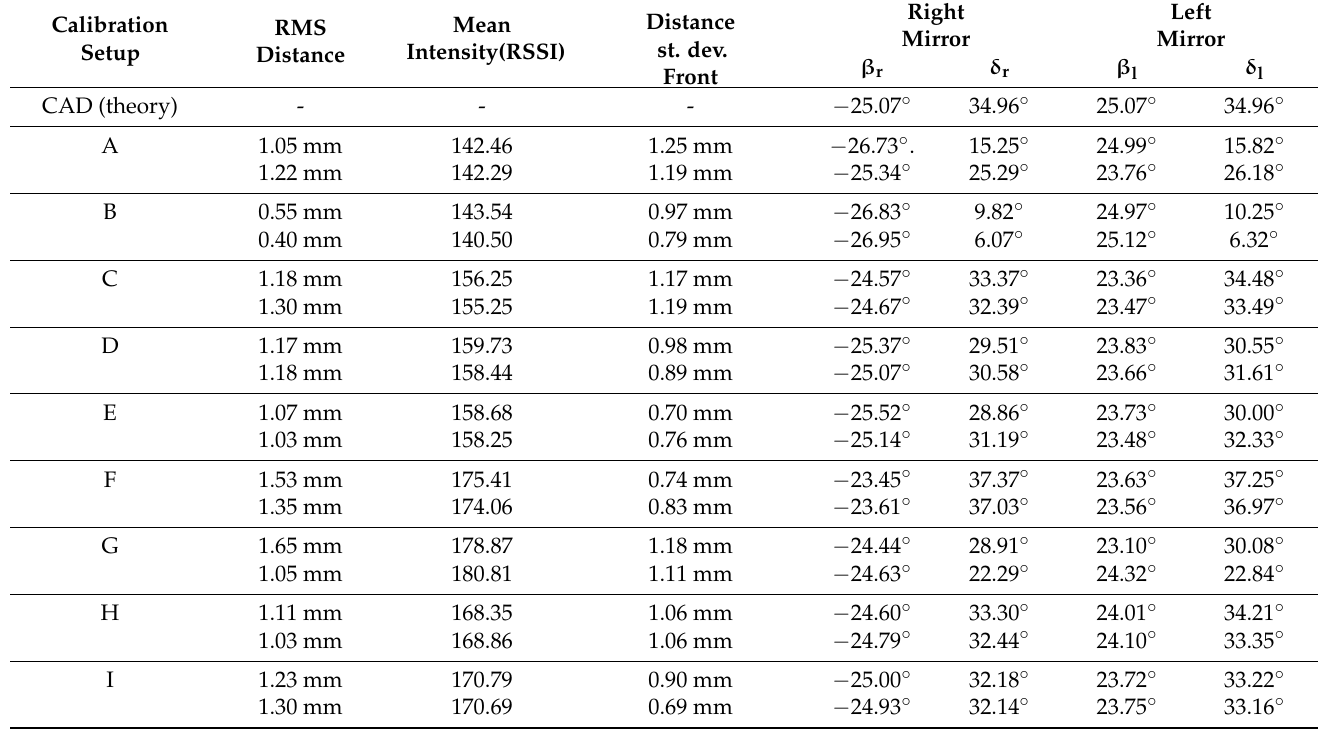
Table 4. Calibration results of the different calibration setups. The resulting quality criteria, as well as the resulting orientation angles of the two mirrors are given. Two lines per calibration setup represent two independent measurements to illustrate the stability of the results. The first line shows results for a calibration performed on a dataset acquired for the stated geometric setup and the results calculated from this dataset. The second line shows these results with the calibration and evaluation procedure repeated on a second independent dataset for the very same geometric